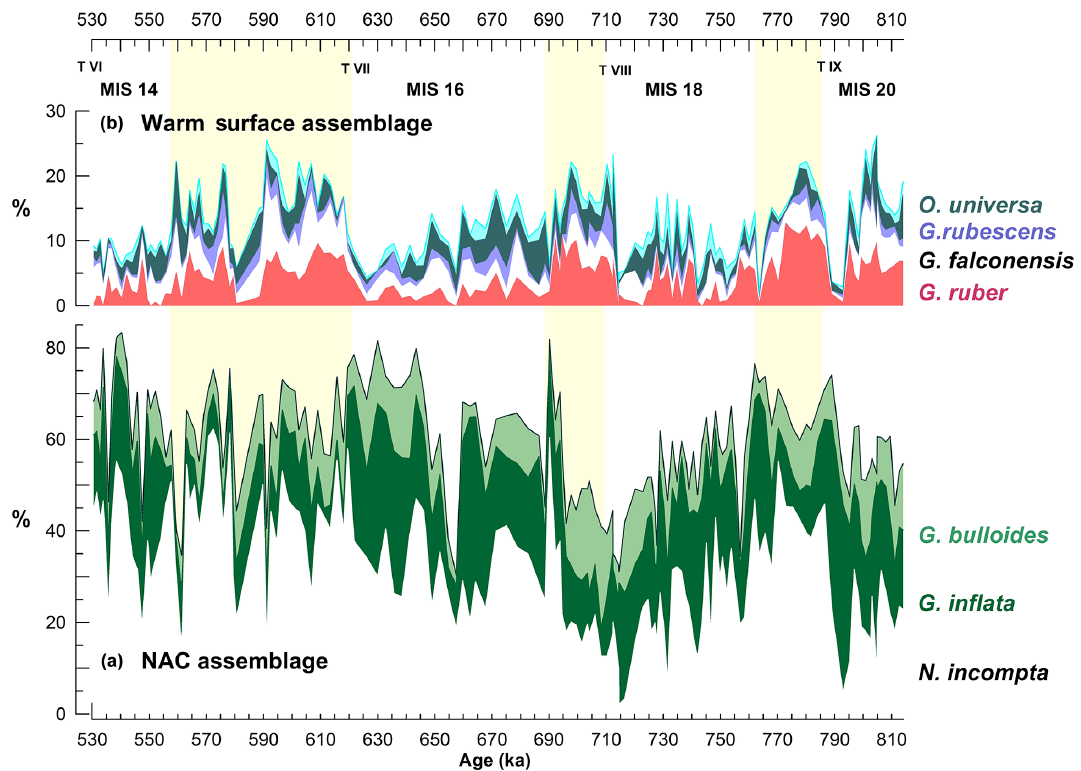
Figure B1. Faunal composition of both the NAC and the warm surface assemblages at site U1385 through the study interval. (a) N. incompta (white), G. inflata (dark green), and G. bulloides (light green). (b) G. ruber (red), G. falconensis (white), G. rubescens (lilac), and O. universa (dark green); and in cyan, other species with less than 1.5% each: G. siphonifera , G. tenella , B. digitata , G. sacculifer , and P. obliquiloculata